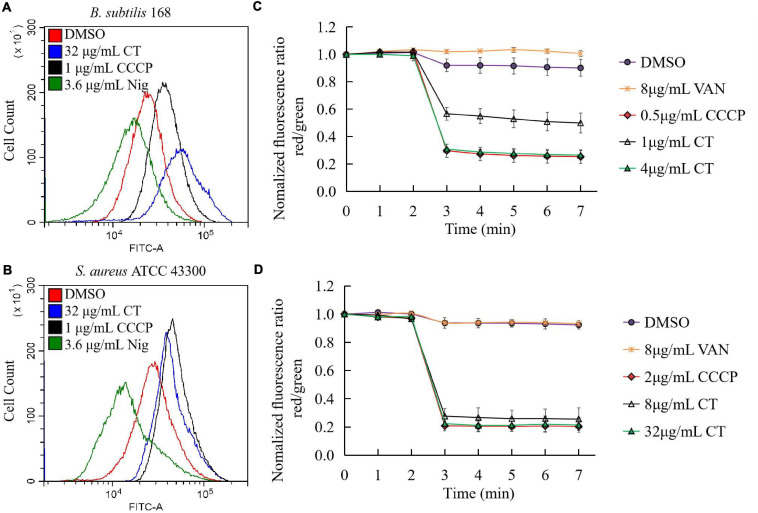
Effect of CT on membrane potential of B. subtilis 168 (A,C) and S. aureus ATCC 43300 (B,D). (A,B) Membrane potential estimation by flow cytometry using DiOC2(3) dye; Representative data from three independent cultures of both strains were shown following exposure to different agents for 10 min. (C,D) Fluorescence of DiOC2(3) was detected at an excitation wavelength of 485 nm and two emission wavelengths, 530 nm (green) and 630 nm (red), using a microplate reader. Addition of CT to the cell suspensions of bacteria is indicated by an arrow. Data are presented as mean ± SD of three independent experiments. DMSO (1.6%), non-drug treated control; CCCP, depolarization control; Nigericin, hyperpolarization control; VAN (vancomycin), negative control.